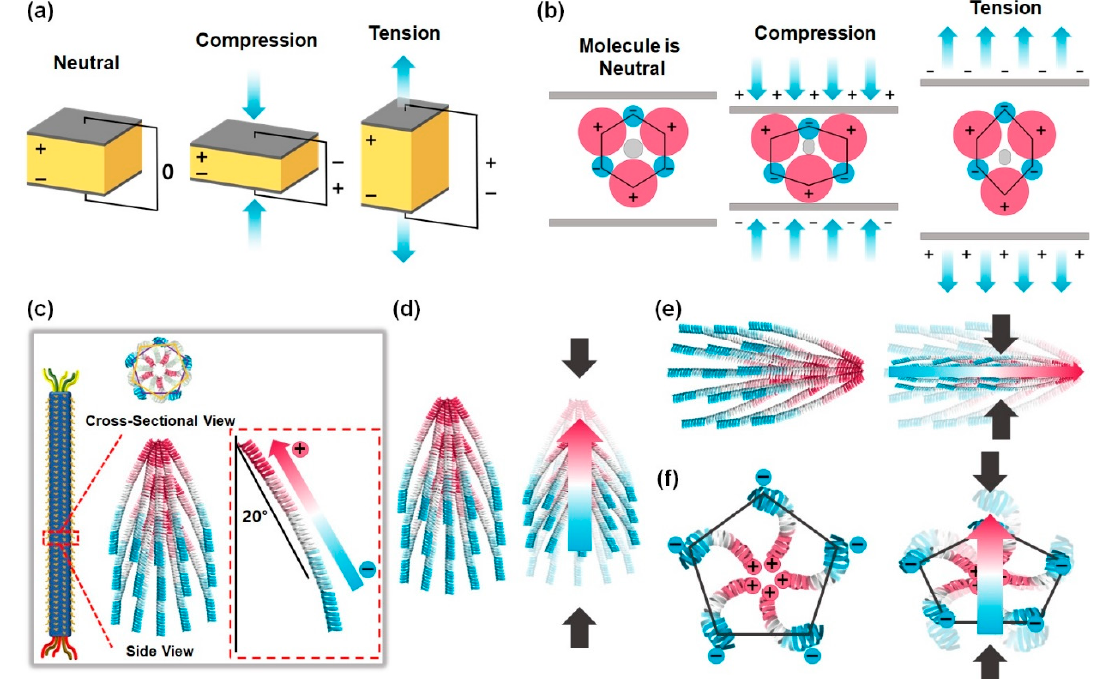
Figure 2. Schematic diagram showing the working mechanism of the piezoelectric effect. ( a ) Diagrammatic demonstration of the piezoelectric effect. ( b ) Schematic illustration showing the working mechanism of the piezoelectric effect in crystal structures. In equilibrium, the charges of the unit cell are neutral (no net dipole moment). When mechanical stresses are applied, a net dipole moment and electrical polarization arise in piezoelectric materials. ( c ) Schematic diagram showing structural characteristics of M13 bacteriophages. M13 phages have five-fold rotational symmetry, two-fold screw symmetry, and no inversion center. Schematic illustrations showing the working mechanism of the piezoelectric effect based on M13 phages when the stress is applied along the phage long axis ( d ) and phage short axis ( e ,f).